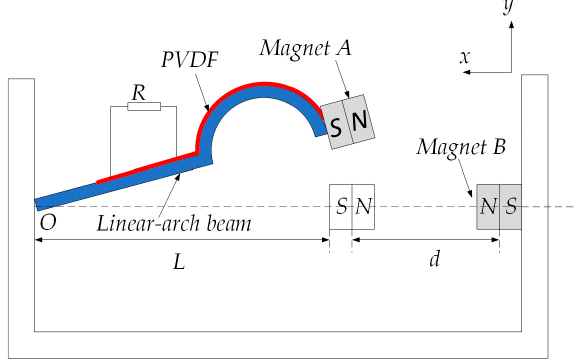
Figure 1. Schematic diagram of LBPEH.